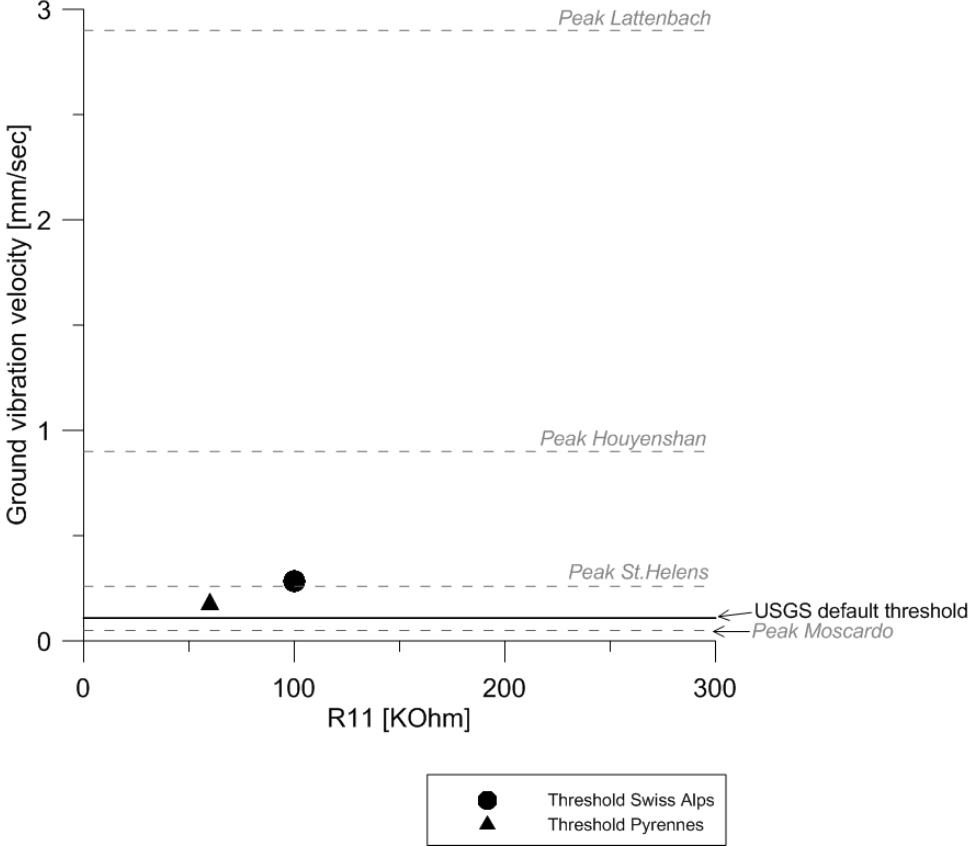
Figure 5. Common threshold values of the monitoring stations in the Pyrenees and the Swiss Alps (indicated by dots), linearly dependent on value R11. Values of ground vibration velocity peaks (dashed grey lines) and thresholds (black continuous line) are given for comparison (see text for detailed explanation on each